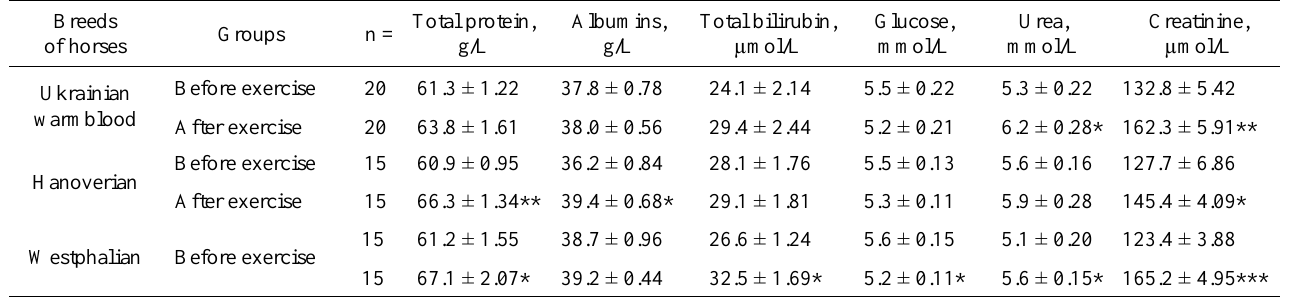
Biochemical parameters of blood serum sport horses before and after exercise Breeds Total protein, Groups n = of horses g/L